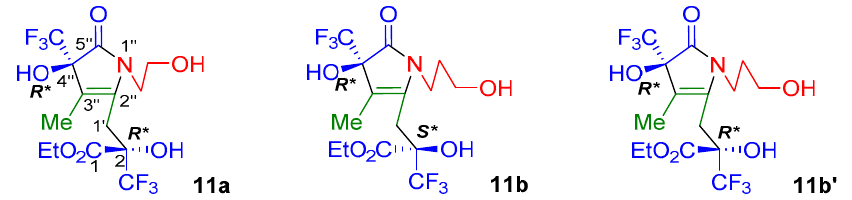
Figure 5. Diastereomeric structure of dihydropyrrol-5-ones 11 .